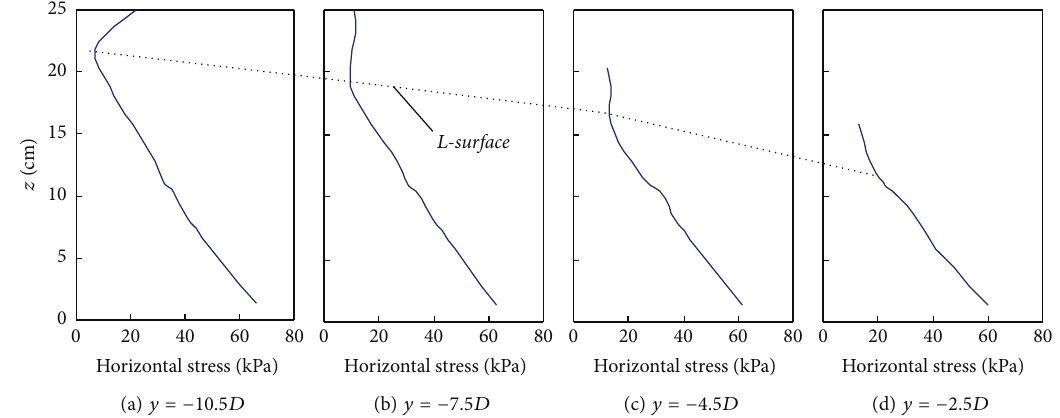
Figure 12: Stress distributions on different vertical sections at 50g-level by numerical analysis.